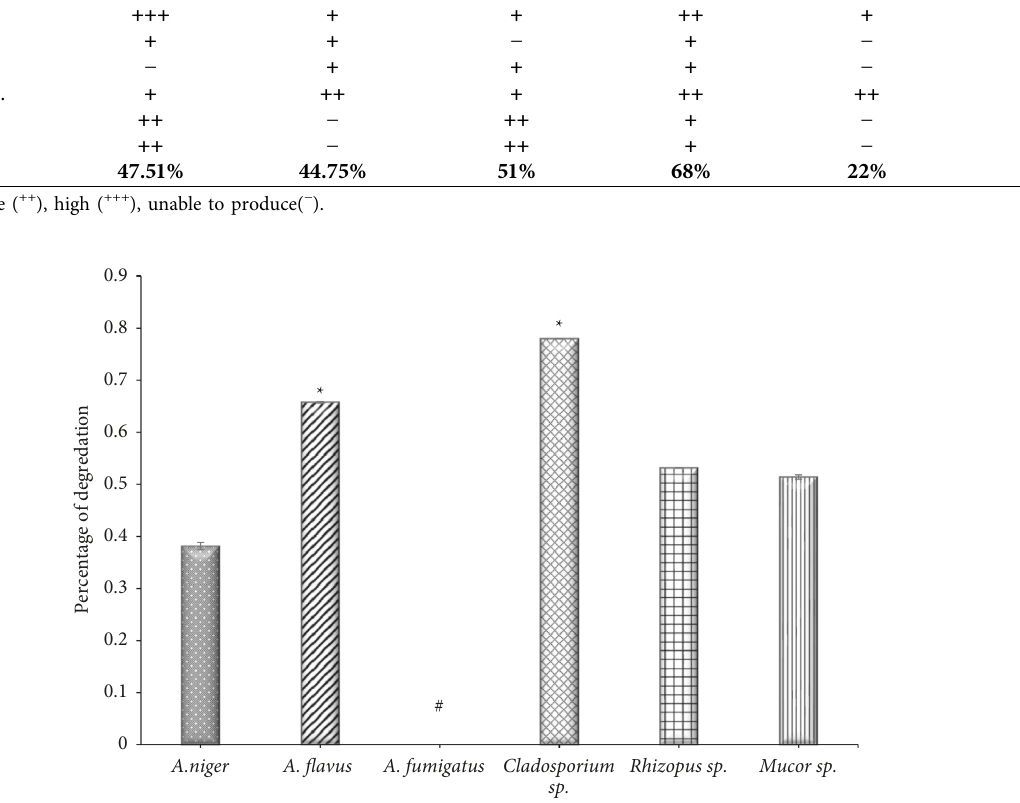
Table 2: Enzymatic activity of endophytic fungi isolated from Ziziphus spina leaves on solid medium. Endophytic fungi